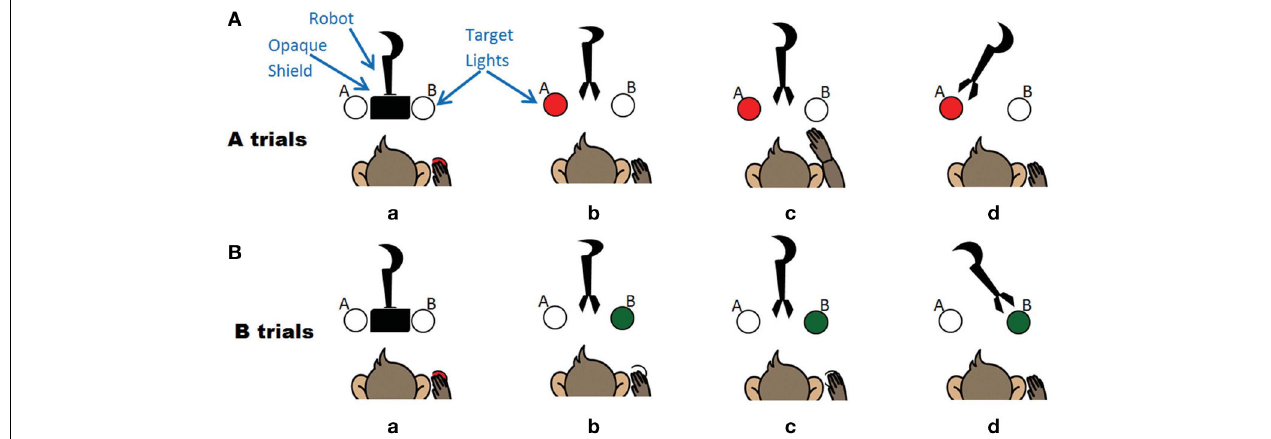
FIGURE 2 | The experiment where the monkey controls the robot arm. (A) A trials associated with a motor high and the left target. Sequence of events (a) monkey triggers trial (b) Robot moves out from opaque screen, target A lights up (c) Monkey makes arm movement (d) Robot moves to